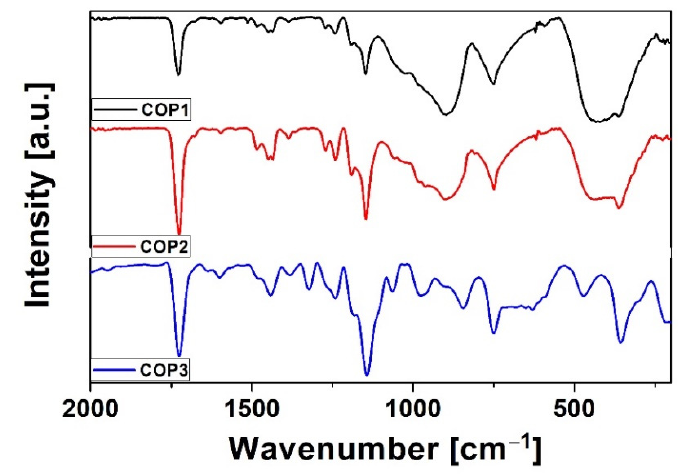
Figure 1. FTIR of styrylquinoline copolymers.